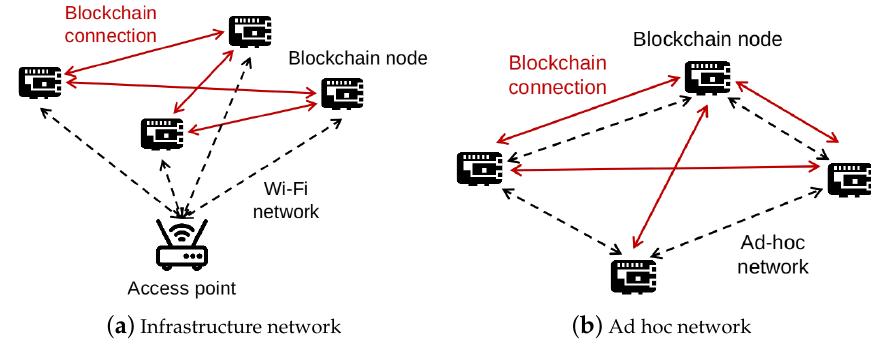
Figure 1. Blockchain-IoT system over an infrastructure network and an ad hoc